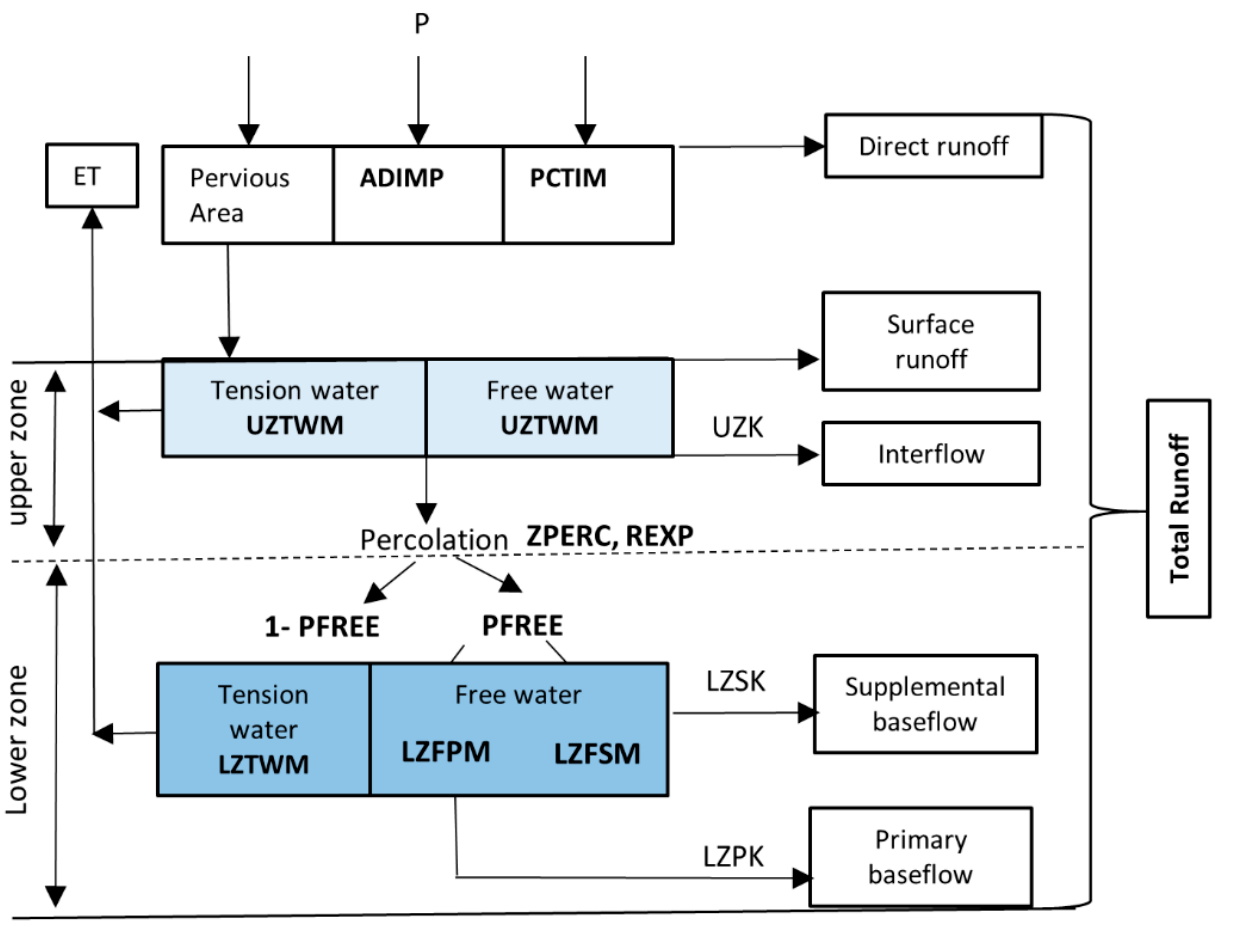
Figure 3. SAC-SMA model Figure 3. SAC ‐ SMA model conceptualization.